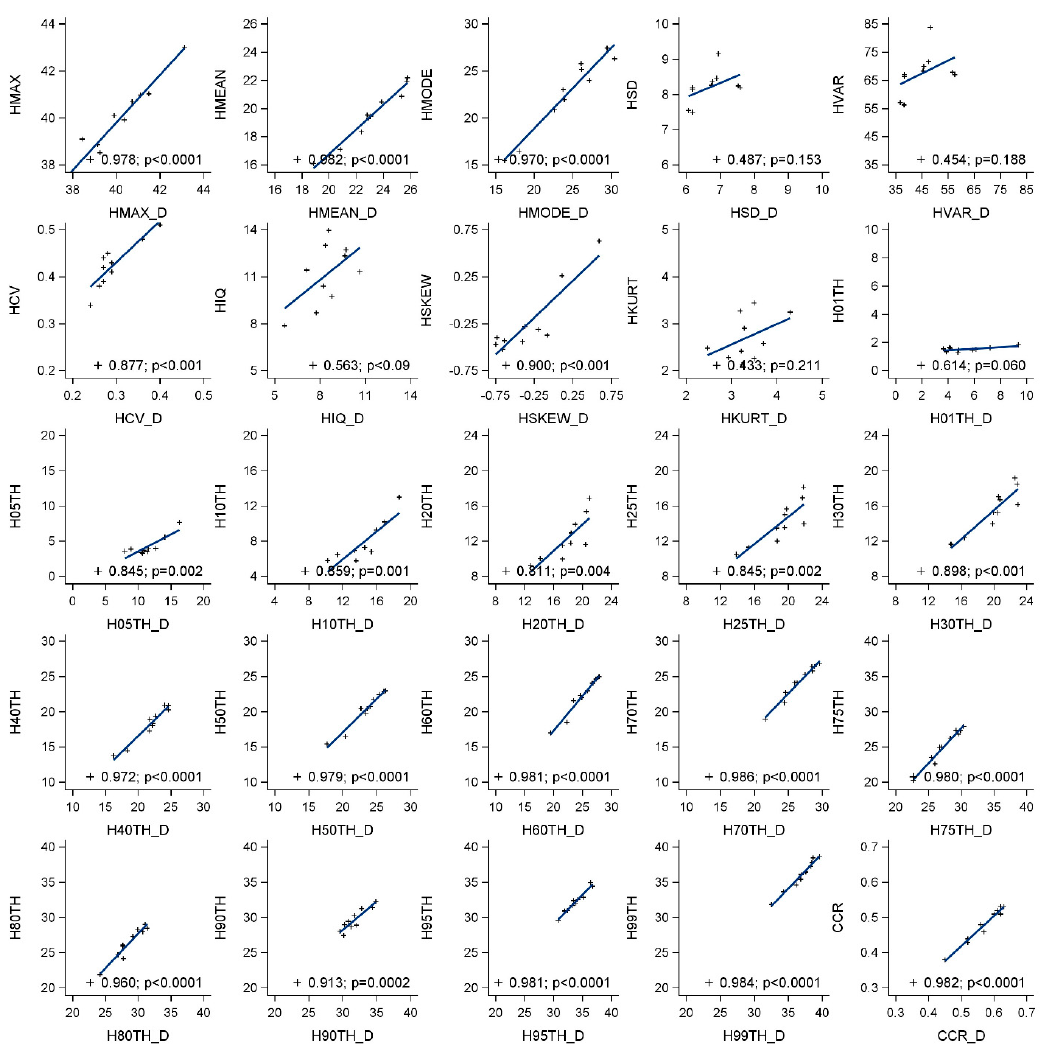
Figure 4. Comparison of the metrics produced by LiDAR sensors on the aircraft and GatorEye systems. Metrics ending with "D" were those calculated using GatorEye LiDAR (a.k.a, drone).